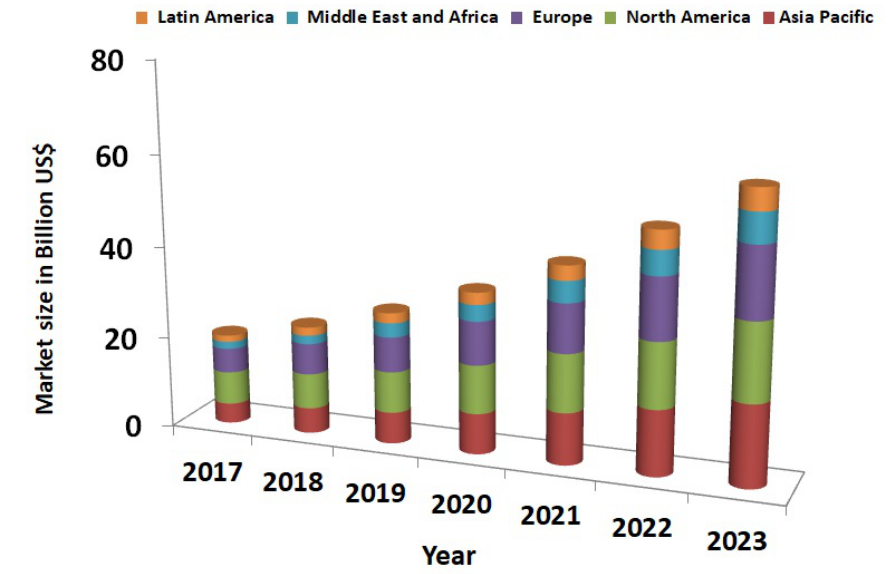
Figure 1. Smart Grid Market Growth